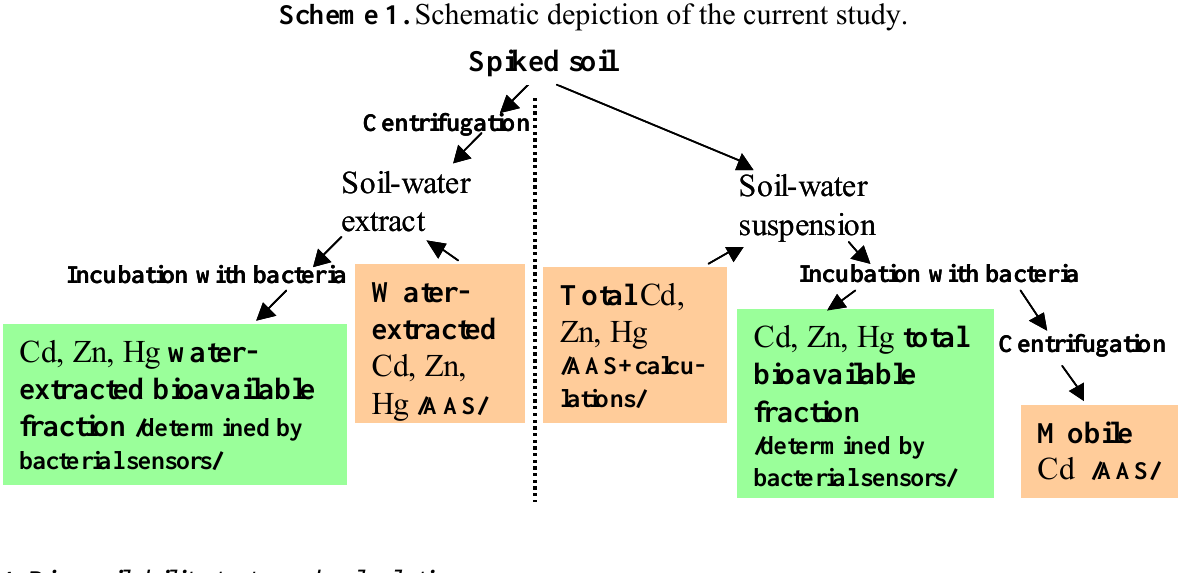
Scheme 1. Schematic depiction of the current